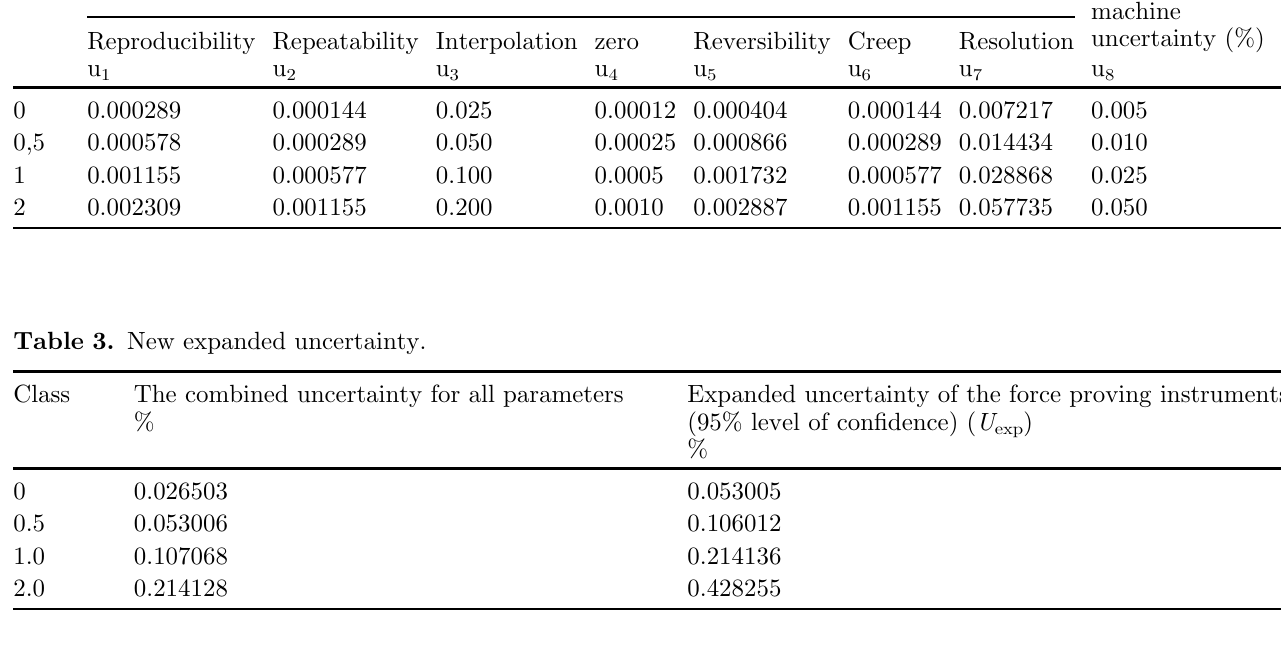
Table 4. Proposed classi fi cation criteria.